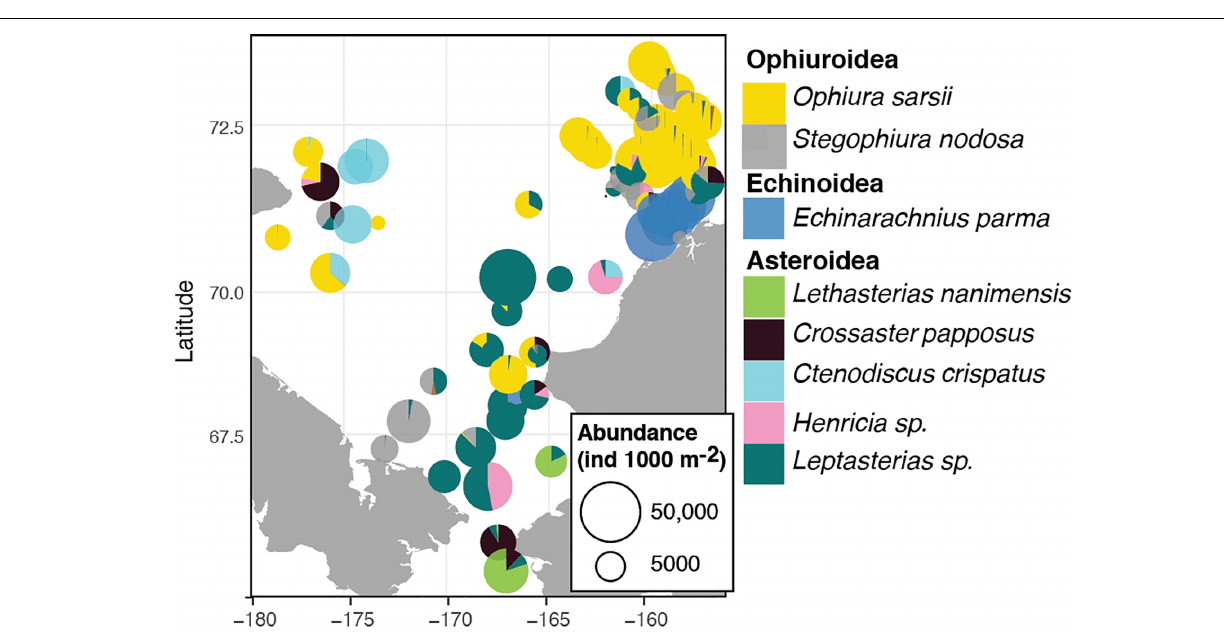
during all other years. Other fairly common larvae included an OTU belonging to the superfamily Galeommatoidea, an OTU identified as belonging to the family Mactridae, and